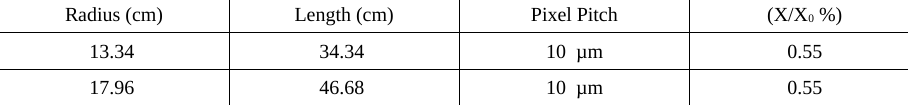
Table 2. The geometric parameters of Silicon Barrel (Sagitta) Layers [10].